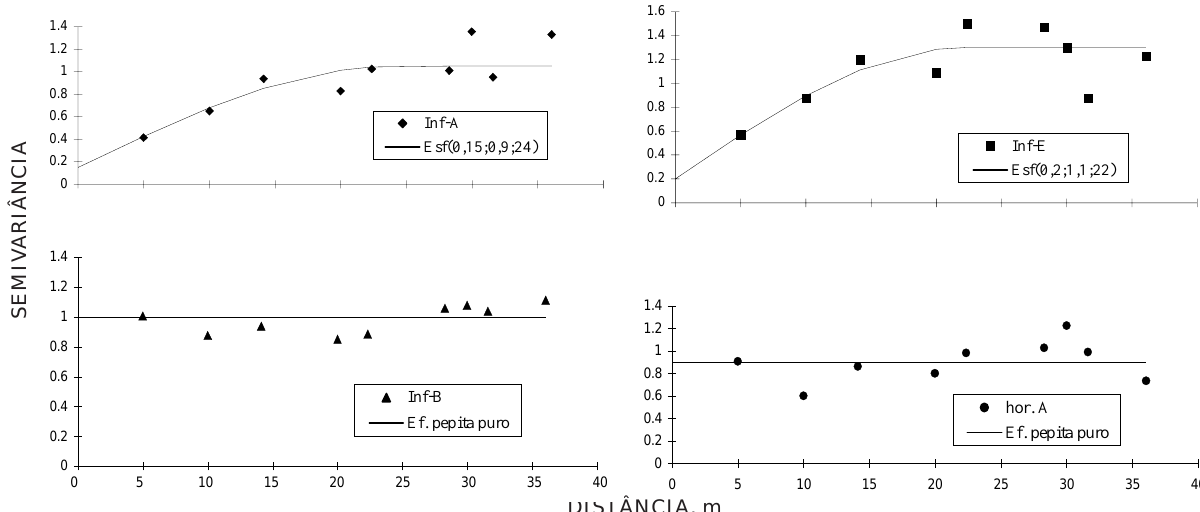
Figura 2. Semivariogramas escalonados da infiltração de água nos horizontes A, E e Bt e da espessura do horizonte A, sob o cultivo de café.